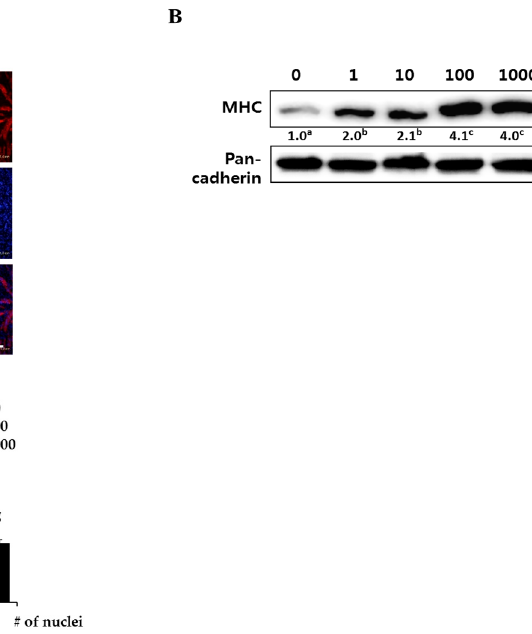
Figure 1. Effect of ethanol extracts of Psoralea corylifolia (EPC) on myogenesis. C2C12 cells were supplemented with differentiation medium (DM), including the indicated concentrations of EPC (1, 10, 100 and 1000 ng/mL) for 3 days, and then cells were collected to perform ( A ) immunostaining of MHC (red) and DAPI (blue) (scale bar = 200 µm) and ( B ) Western blot analysis to determine the level of myosin heavy chain (MHC) expression. The level of MHC protein was quantified and normalized to pan-cadherin. Values are mean ( n = 3). The images are representative of three independent experiments with similar results. Means without a common superscript differ significantly ( p < 0.05).